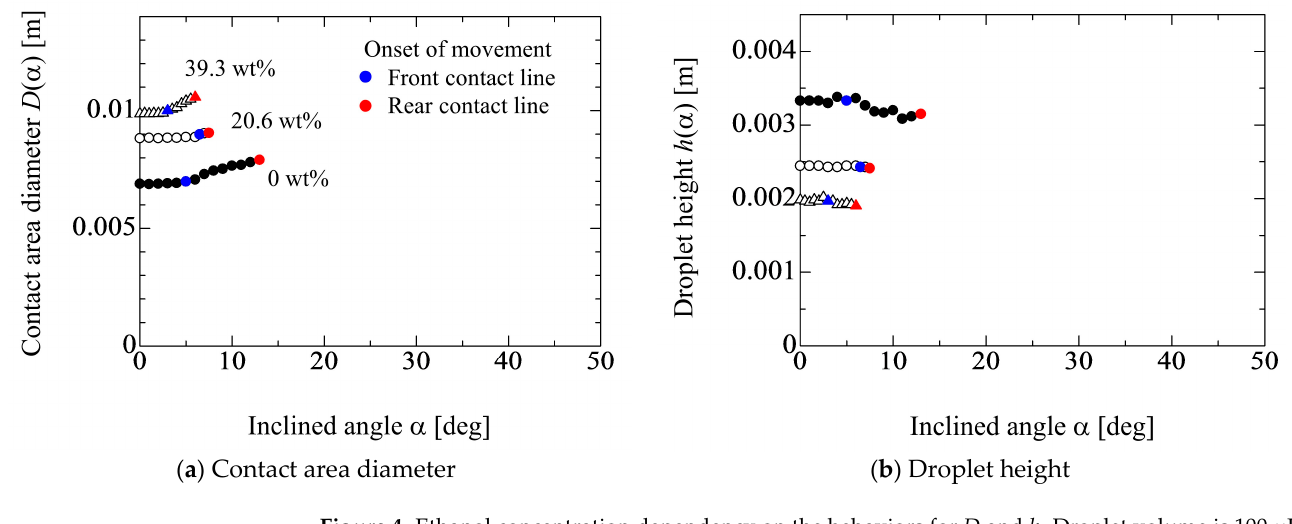
Figure 4. Ethanol concentration dependency on the behaviors for D and h . Droplet volume is 100 µ L. The blue and red characters represent the front and rear contact lines movement, respectively.